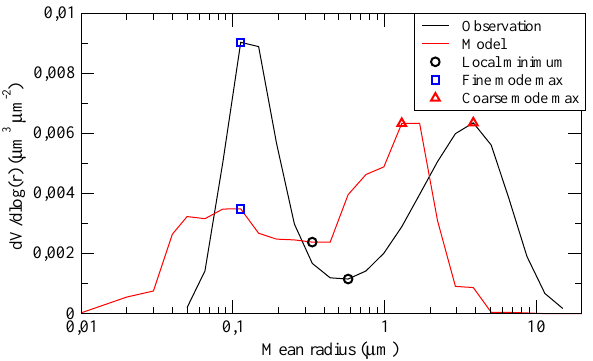
Figure 10. Method for the local minima and maxima values esti- mation. This example corresponds to the ASD for Athens, 23 July 2013,